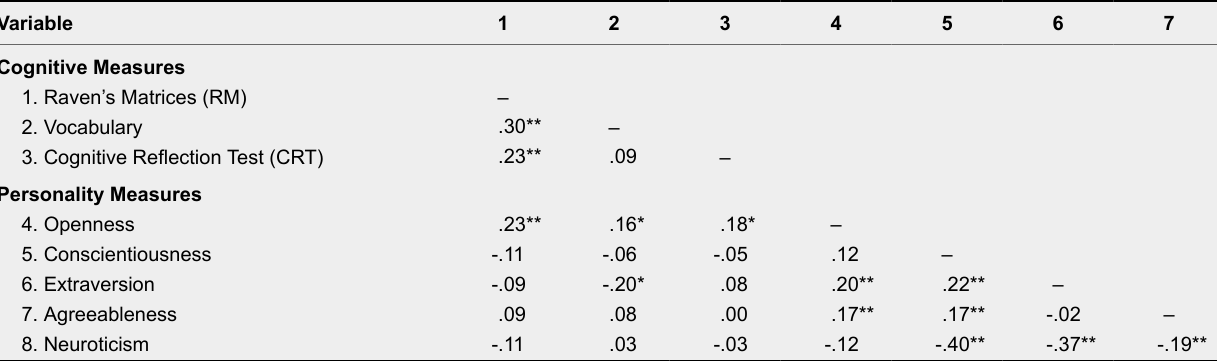
Correlations Among Cognitive Variables and Personality Traits